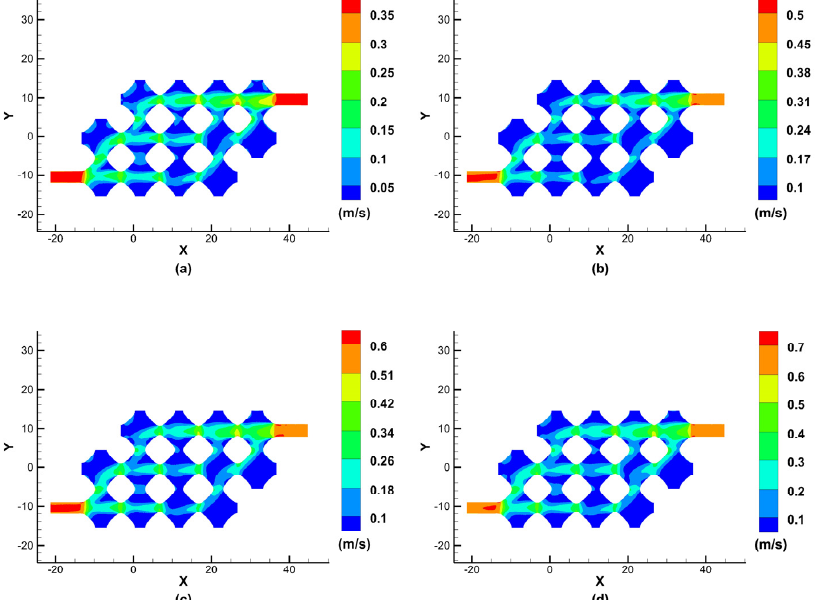
Figure 8. Simulation results of the fluid velocity at different perfusion pressures after optimisation: ( a ) 12 mmHg; ( b ) 13 mmHg; ( c ) 14 mmHg; ( d ) 15 mmHg.